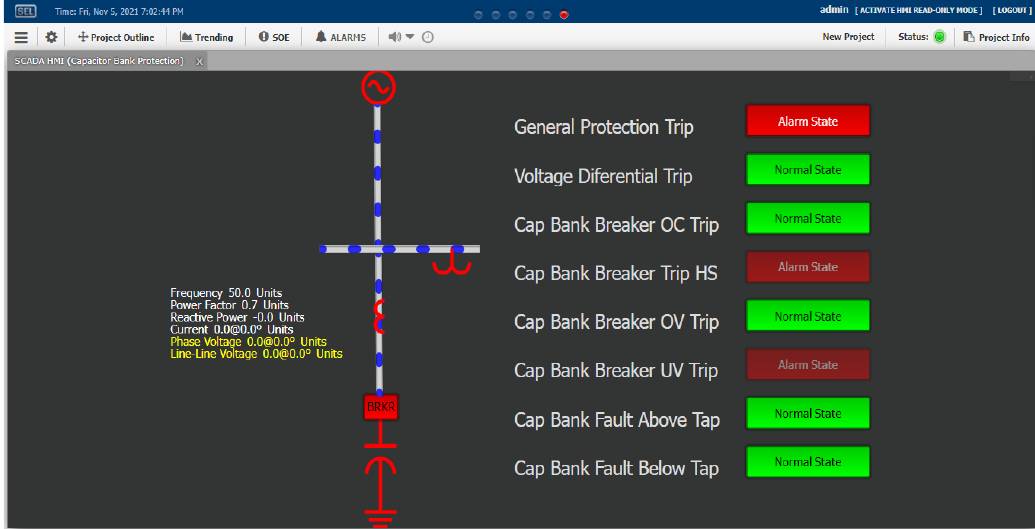
Figure 7. Human Machine Interface for five element failures below the tap.